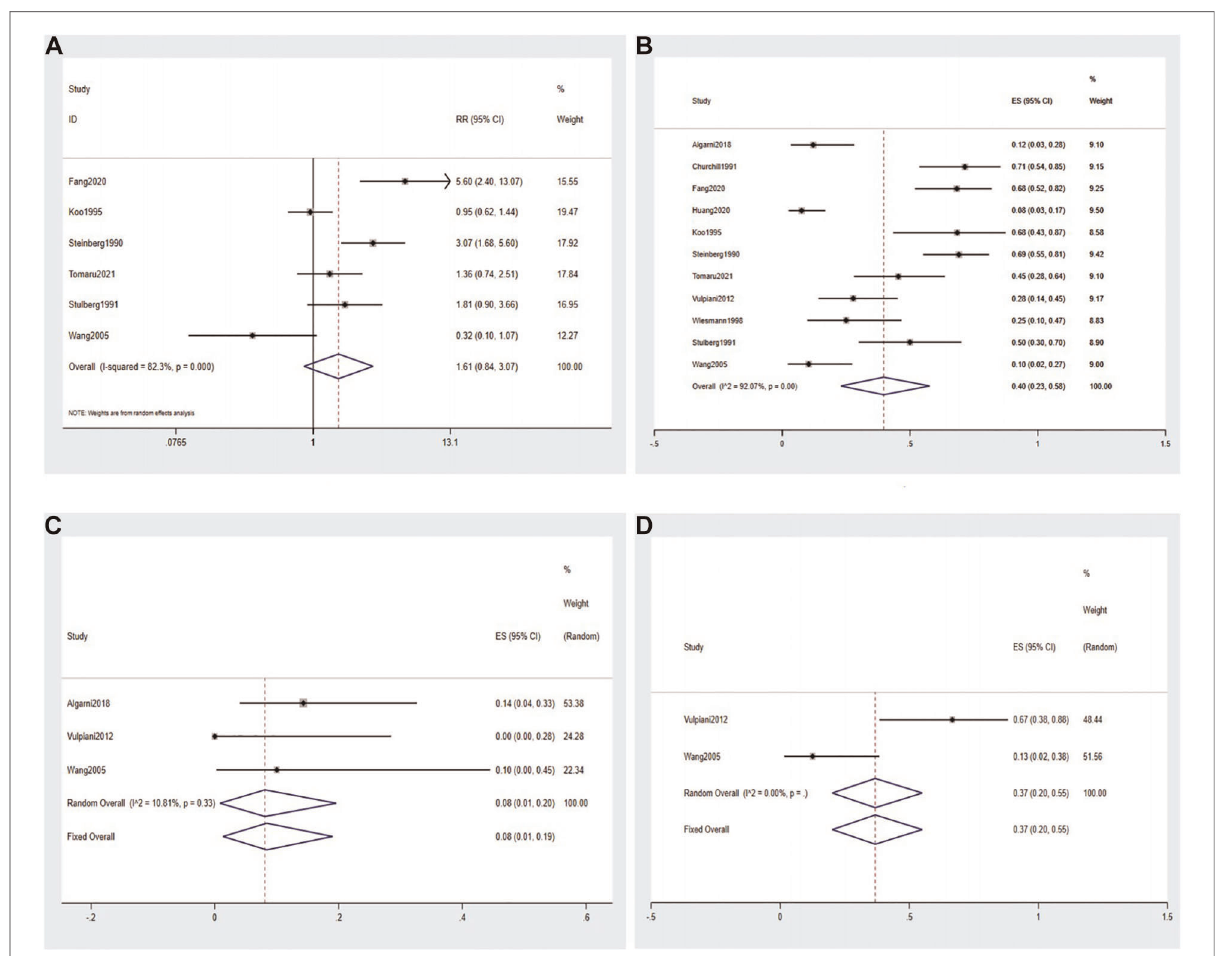
FIGURE 3 Forest plot of the THA rate. ( A ) The forest plot of the random effects model for 2 RCTs and 4 comparative studies; ( B ) the forest plot of the random effects model for a single-arm meta-analysis of 11 studies; ( C ) the forest plot of the fi xed-effects model for a single-arm meta-analysis of 3 studies (ARCO stage II); ( D ) the forest plot of the fi xed-effects model for a single-arm meta-analysis of 2 studies (ARCO stage